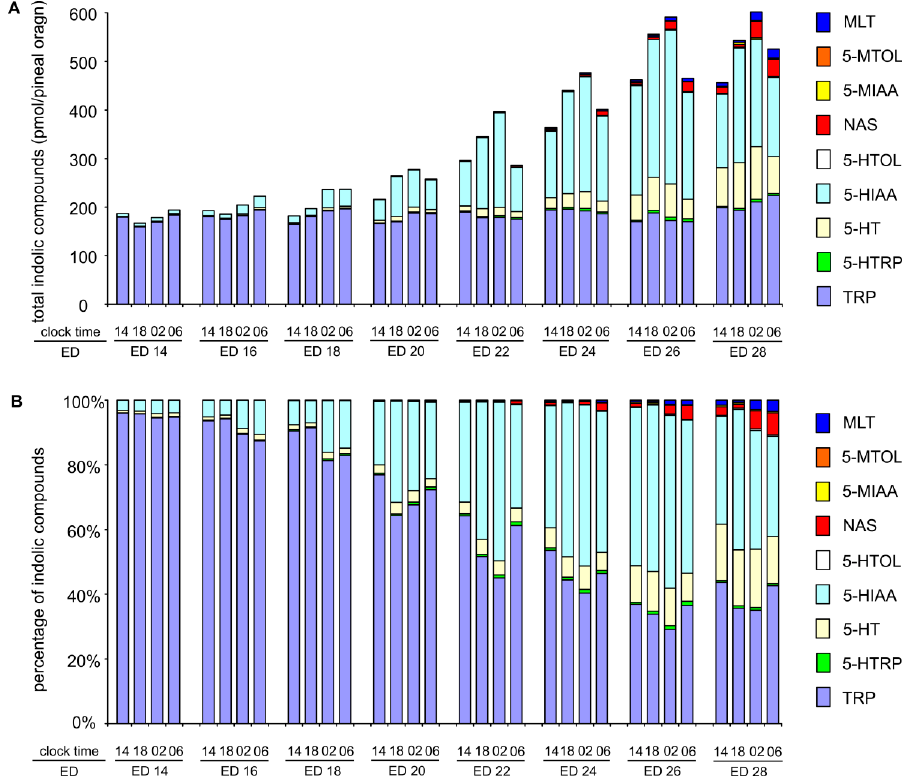
Figure 6. Changes in the stoichiometric relationships between indoles in the geese pineal organ during embryonic development expressed as absolute values ( A ) and percentages ( B ).